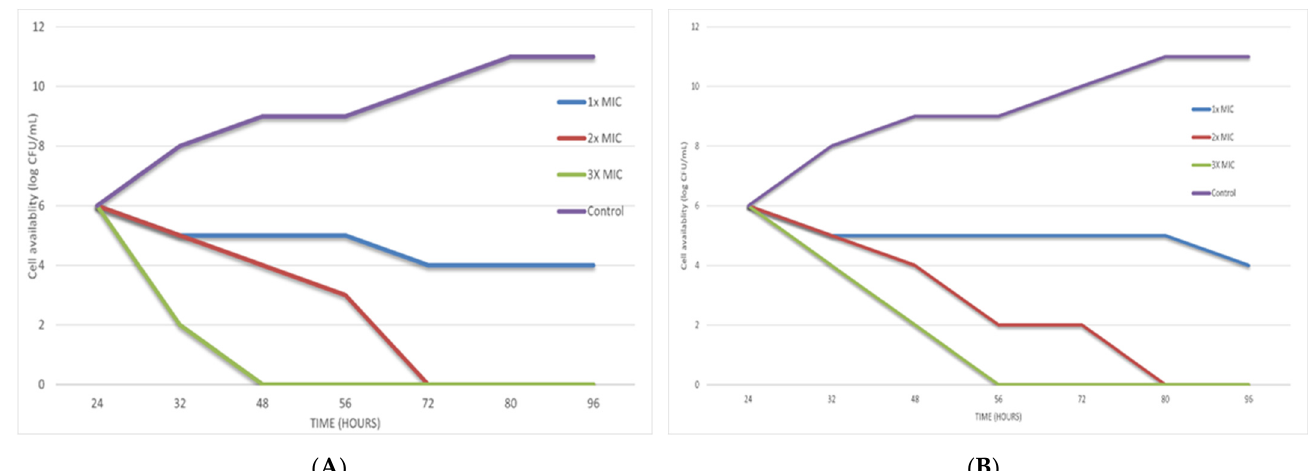
Figure 2. Time-kill curves of the extracts ( A ) DES2: Tailor R. officinalis and ( B ) DES3:CHGl extracts of R. officinalis against MDR –M. tuberculosis. R. officinalis against MDR- M. tuberculosis